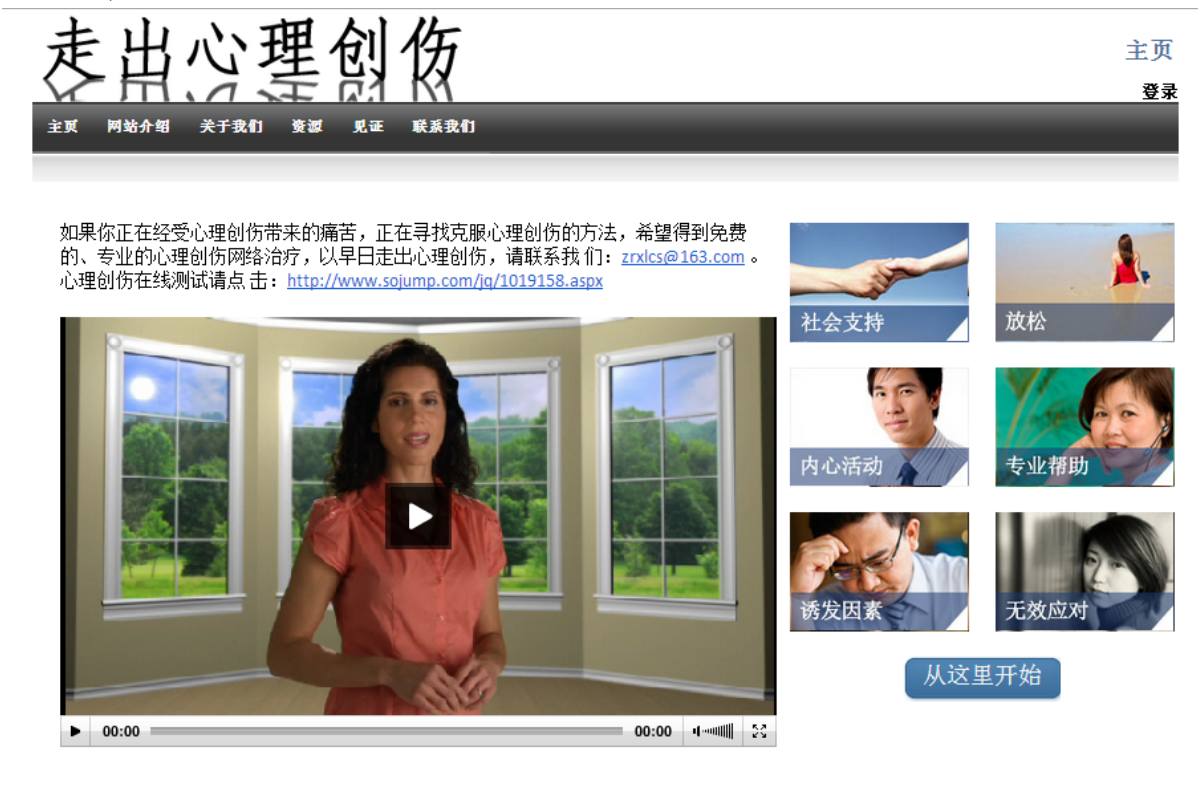
Figure 1. Example screenshot of the CMTR